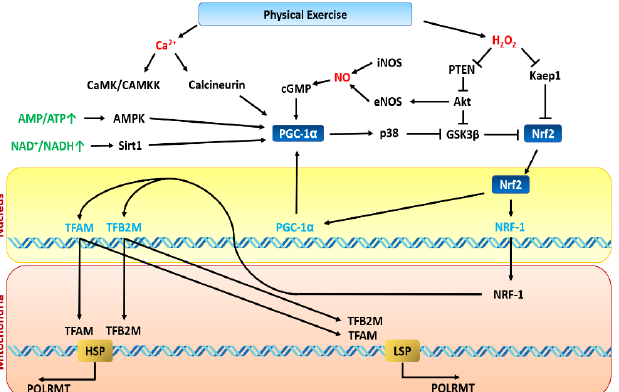
Figure 4. Oxidative transcriptional regulatory loop. Adapted from Gureev et al. [277]. Exercise promotes reactive oxygen species (ROS) generation, which leads to the relief of tonic inhibition of Keap1 on Nrf2. Nrf2 is also activated in a PGC ‐ 1 α dependent mechanism. Nrf2 promotes NRF1 (enables the transcription of mitochondrial transcription factors, mitochondrial transcription factor A (TFAM) and transcription factor B2, mitochondrial (TFB2M)) and PGC ‐ 1 α , establishing a positive feedback loop of pro ‐ oxidative signalling in response to exercise ‐ induced increments in ROS, NO, Ca 2+ , adenosine monophosphate (AMP), and oxidized nicotinamide adenine dinucleotide NAD + .